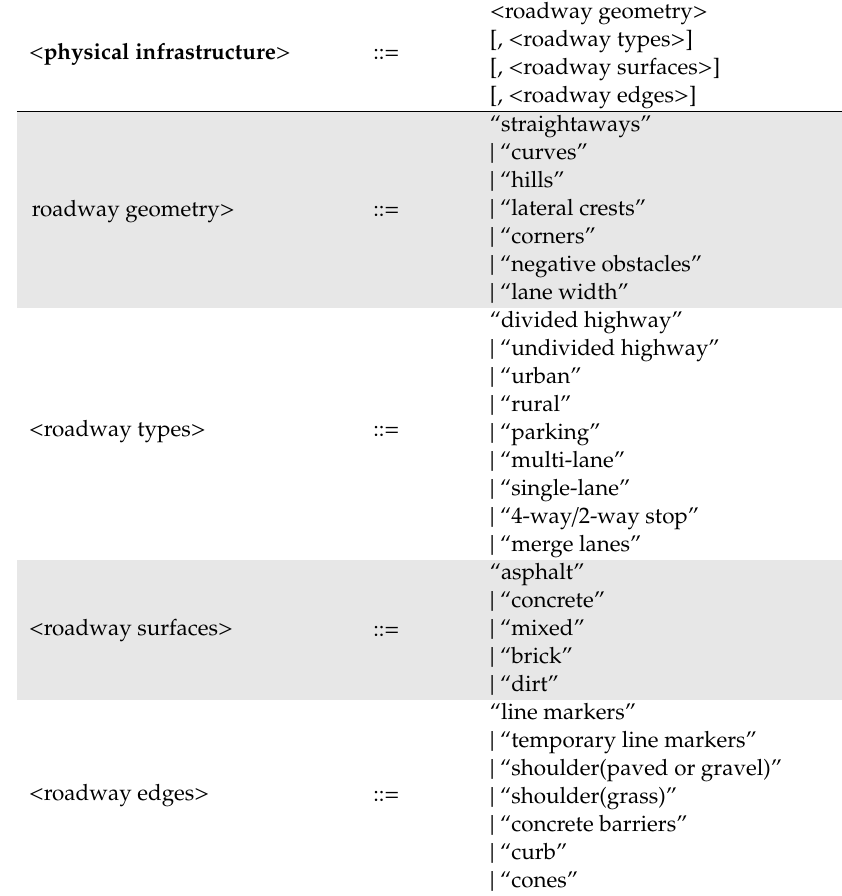
Table A4. The 3rd stage of < environment >< physical infrastructure > .